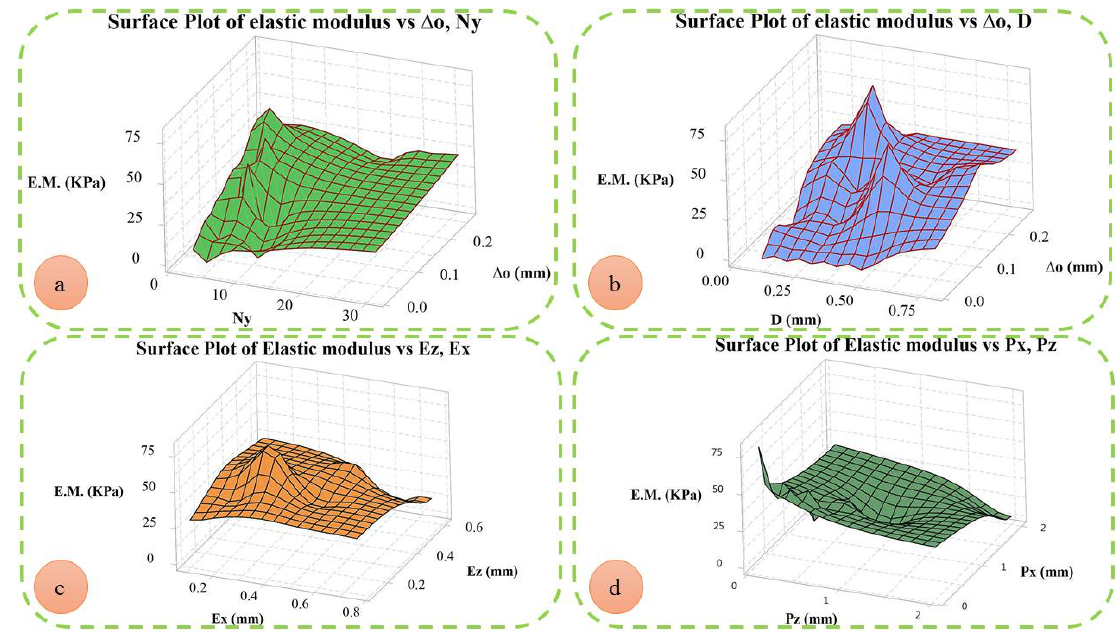
Figure 8. Effect of ( a ) Δ 0 and N y ; ( b ) Δ o and D ; ( c ) E x and E z ; and ( d ) P z and P x on the elastic modulus (EM).